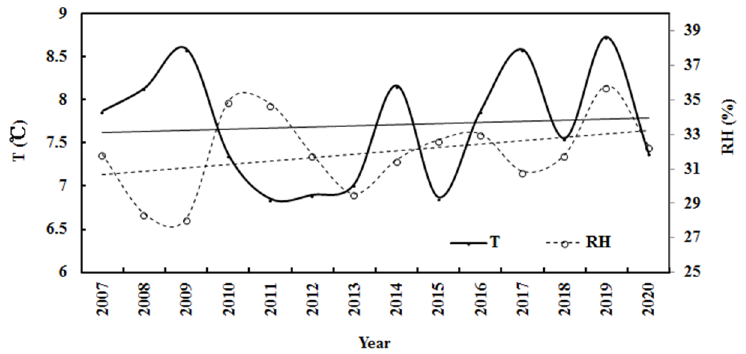
Figure 9. Annual air temperature (T) and relative humidity (RH) at the Qomolangma site during 2007–2020. The lines are linear fits to the data for T (upper line) and RH (lower line).